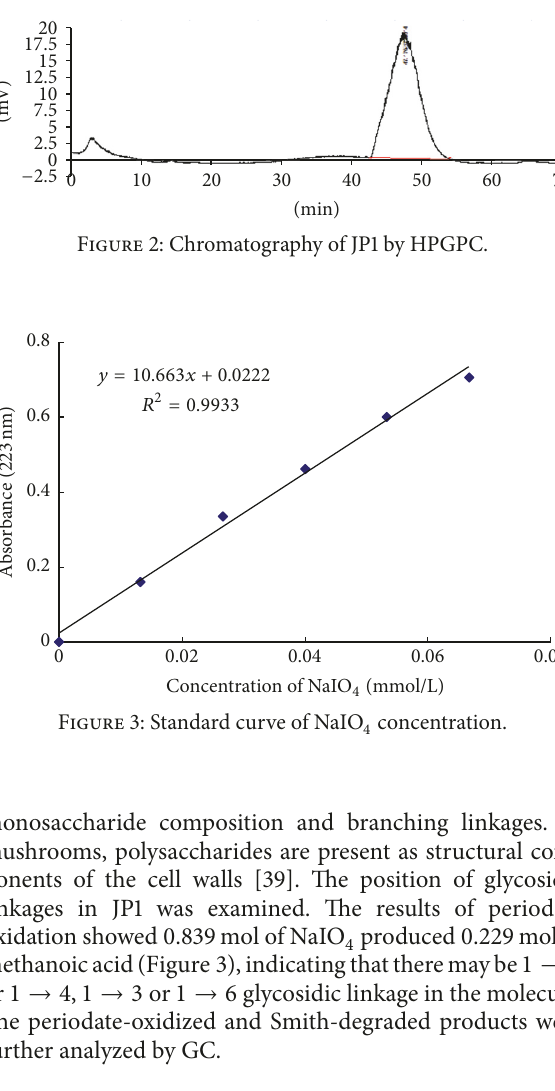
monosaccharide composition and branching linkages.